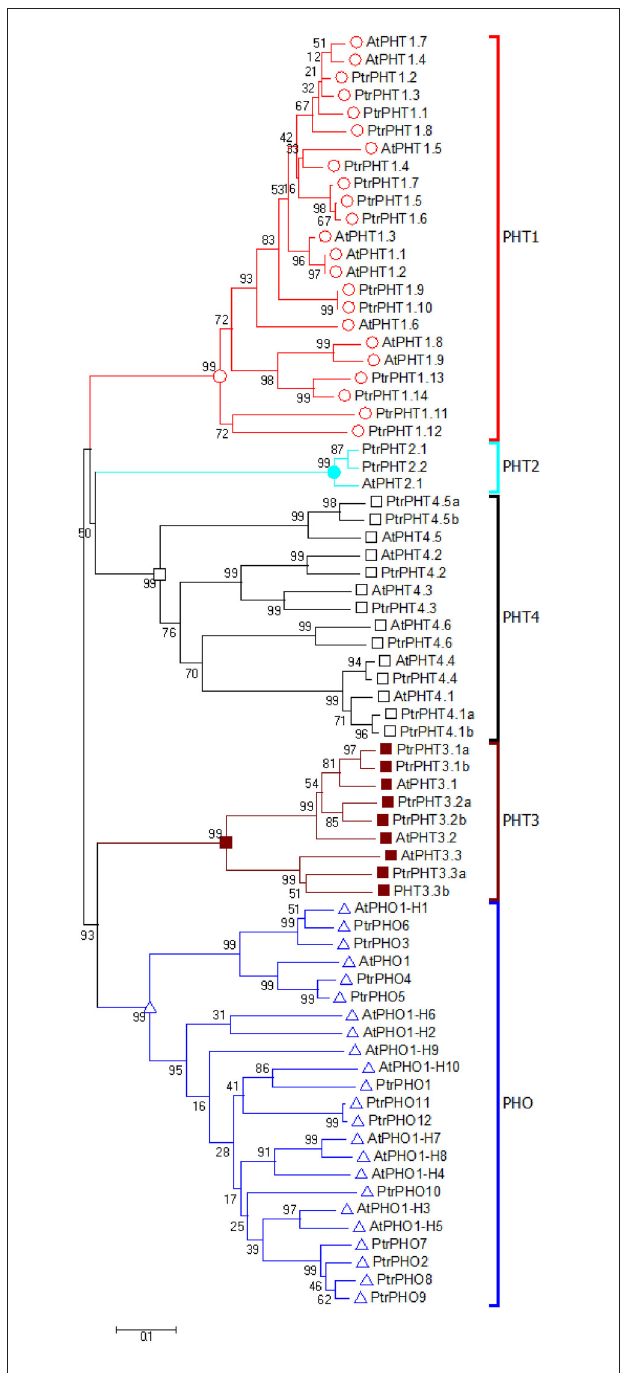
FIGURE 1 | Phylogenetic tree of P. trichocarpa and A. thaliana PHT proteins. The phylogenetic tree was constructed using the neighbor-joining method with the 1000 bootstrap in MEGA 6 (http://www.megasoftware.net/).